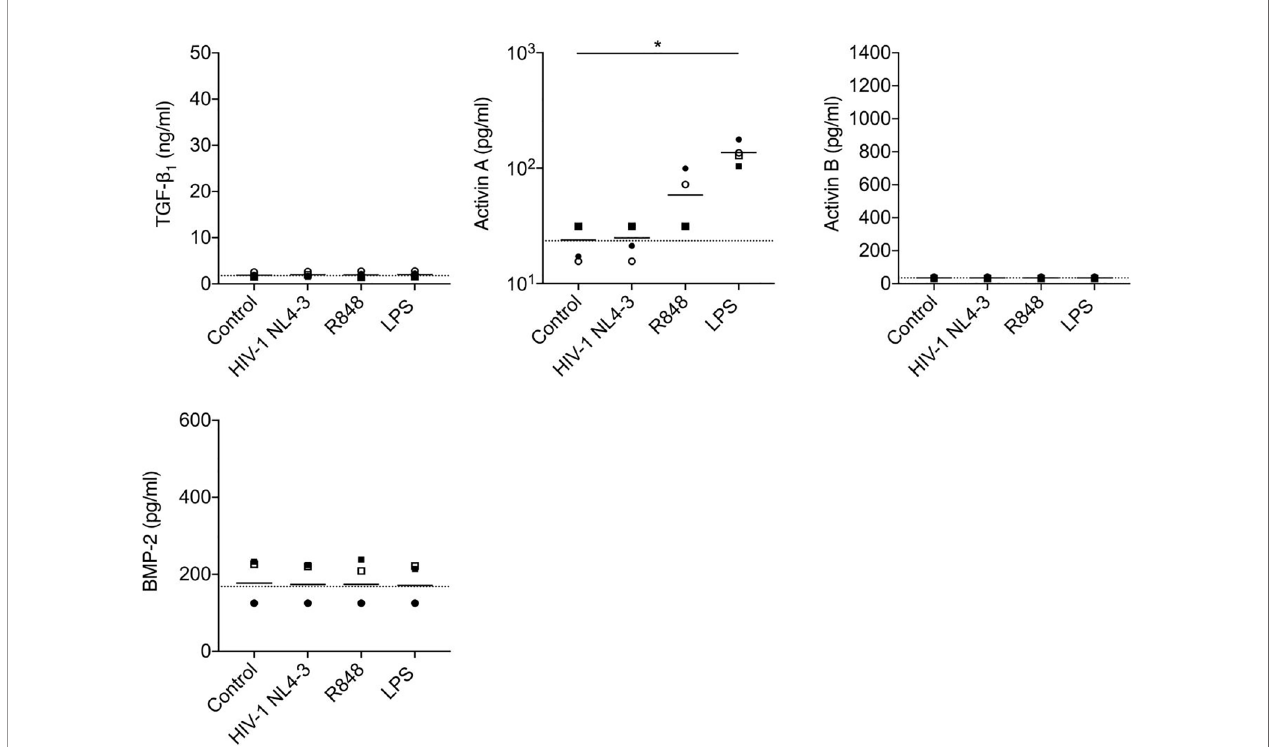
FIGURE 6 | Analysis of production of TGF- b superfamily cytokines by mDCs following in vitro stimulation with HIV-1 or TLR ligands. mDCs from n=4 healthy donors were cultured with medium only, HIV-1 NL4-3, TLR7/8 agonist R848 or LPS. Concentrations of TGF- b superfamily cytokines in supernatants were measured after 24 h. The horizontal dashed line shows background analyte levels in serum-containing medium (mean of values measured in two independent experiments). Symbols represent data from four individual donors, solid lines indicate the group means. Data were analyzed using a one-way ANOVA with Dunnett ’ s post-test comparing each group to the unstimulated mDC control (*P <